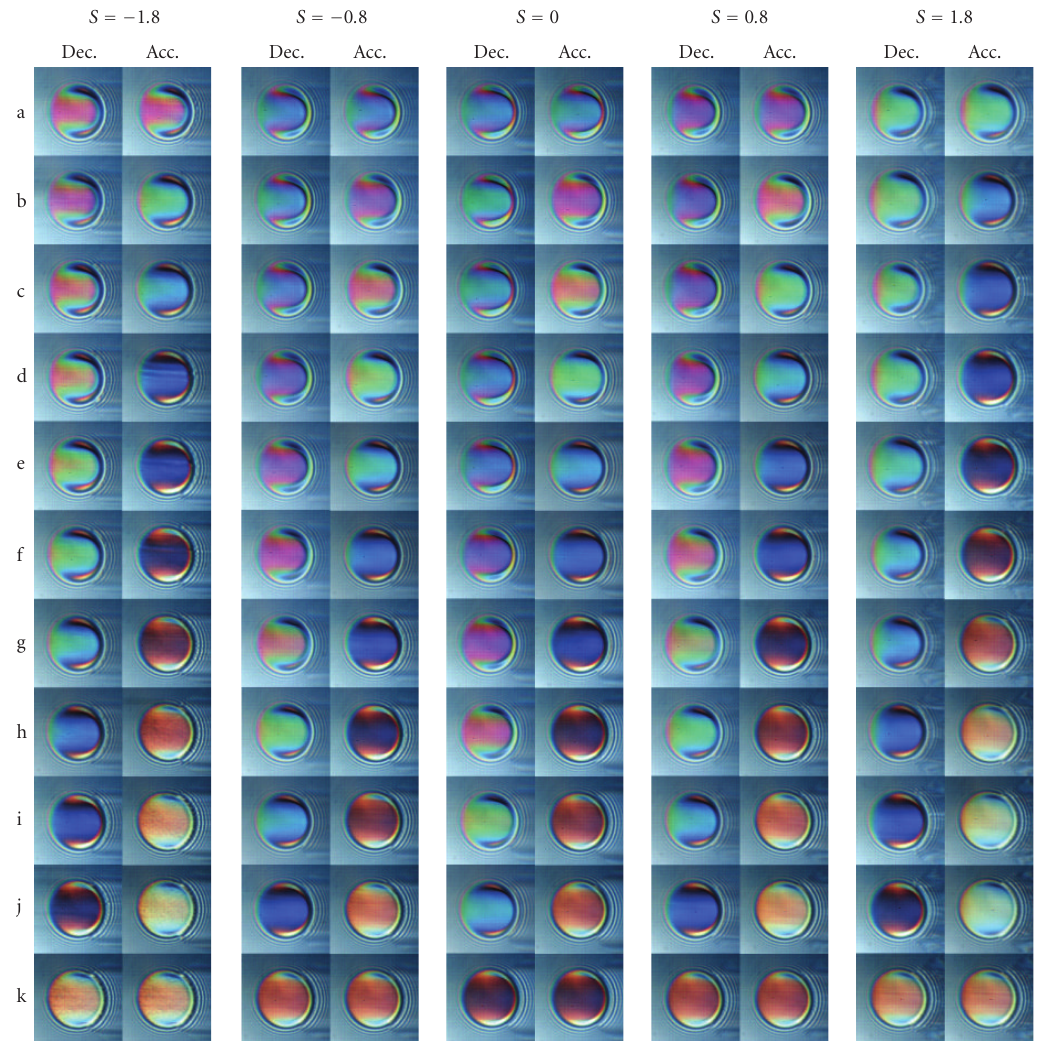
Figure 14: Interferograms obtained under transient conditions. Test frequency: 0.25 Hz. (Entraining velocities u e : a = 0.2250, b = 0.2065, c = 0.1880, d = 0.1695, e = 0.1510, f = 0.1325, g = 0.1140, h = 0.0955, i = 0.0770, j = 0.0585, k = 0.0400